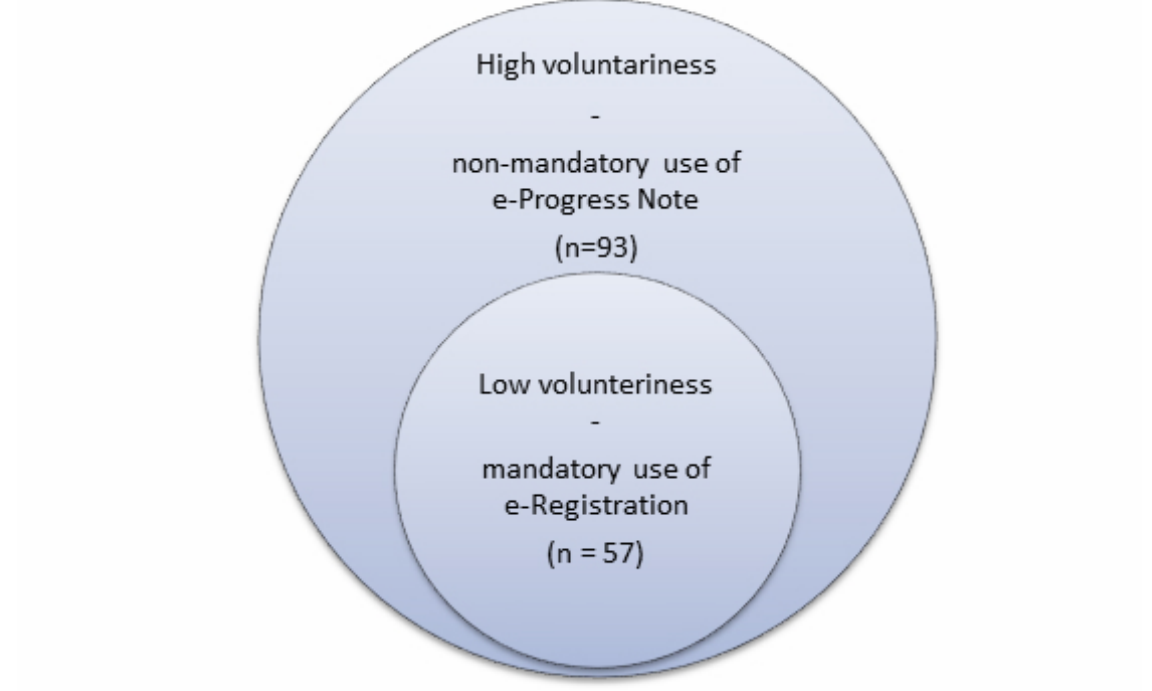
Figure 2. The sample distribution in the high and low voluntariness